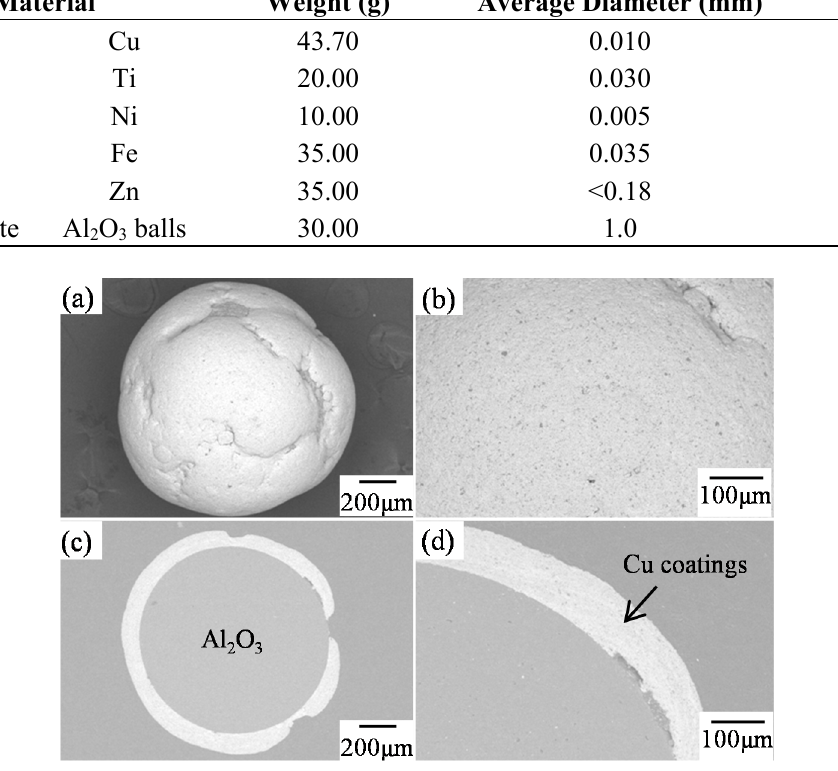
Figure 8. Cu coatings by MCT at 480 rpm for 20 h. ( a , b ) Surface structure; ( c , d ) Cross sectional structure.